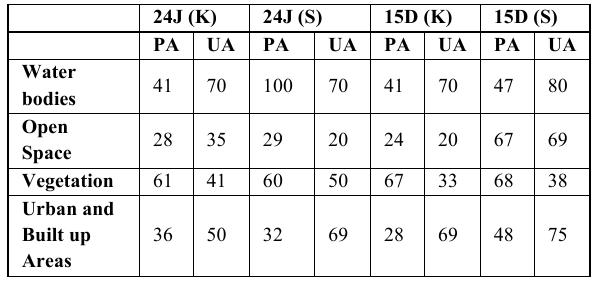
Table 1: Accuracy Assessment; PA: Producer's Accuracy; UA: User's Accuracy; 24J: 24th July; 15D: 15th December; (K): K-Means Clustering; (S): Supervised classification